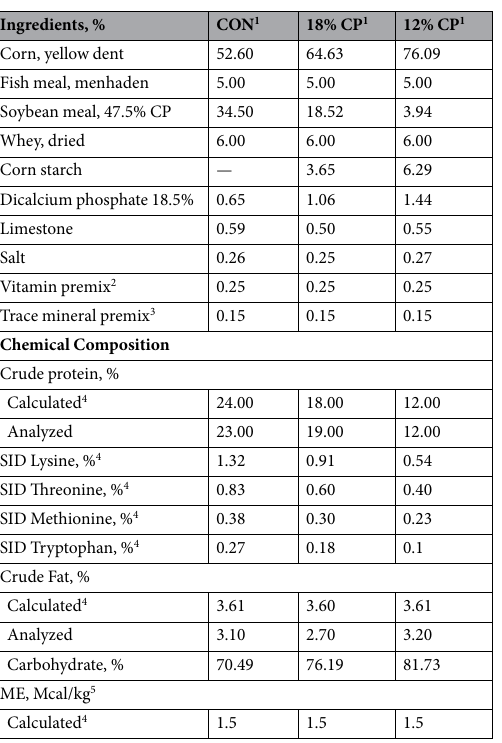
Table 3. Composition of experimental diets (as-fed basis). 1 CON, control diet with 24% crude protein (CP); 18% CP, low protein diet with 18% CP; 12% CP, low protein diet with 12% CP. 2 Vitamin mix provided per kilogram of diet: vitamin A, 720,000 IU; vitamin D, 180,000 IU; vitamin E, 5,400 mg; vitamin K3, 360 mg; vitamin B12, 3.15 mg; niacin, 6,750 mg; pantothenic acid, 2,250 mg; riboflavin, 675 mg; phytase, 61,200 FTU. 3 Mineral mix provided per kilogram of diet: copper sulfate, 11,000 ppm; iodine, 198 ppm; iron, 73,413 ppm; manganese, 22,046; selenium, 198 ppm; zinc, 73,413 ppm. 4 Values were calculated using National Swine Nutrition Guide (NSNG; V 2.0) software; standard ileal digestibility (SID). 5 Metabolizable energy